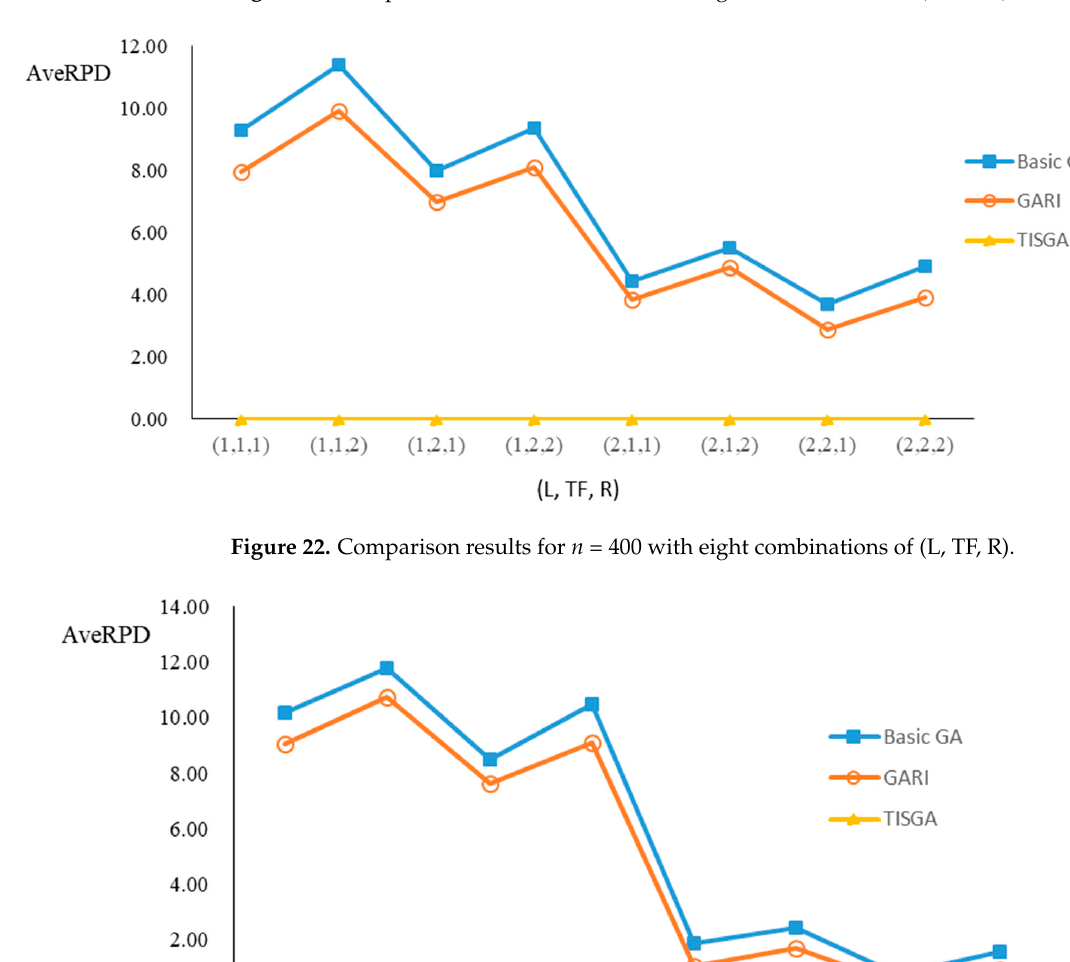
Figure 21. Comparison results for n = 300 with eight combinations of (L, TF, R).